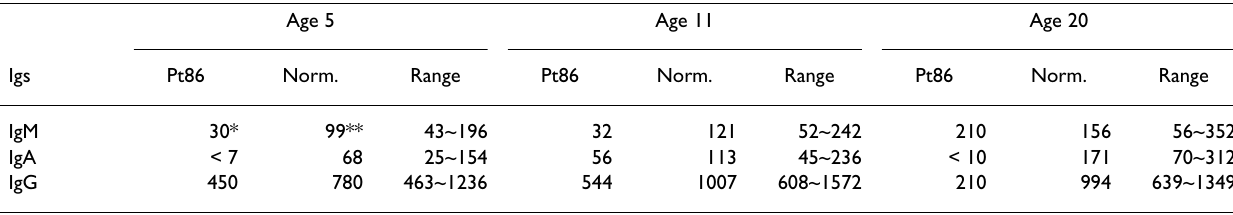
Table 1: Serum immunoglobulin levels of patient